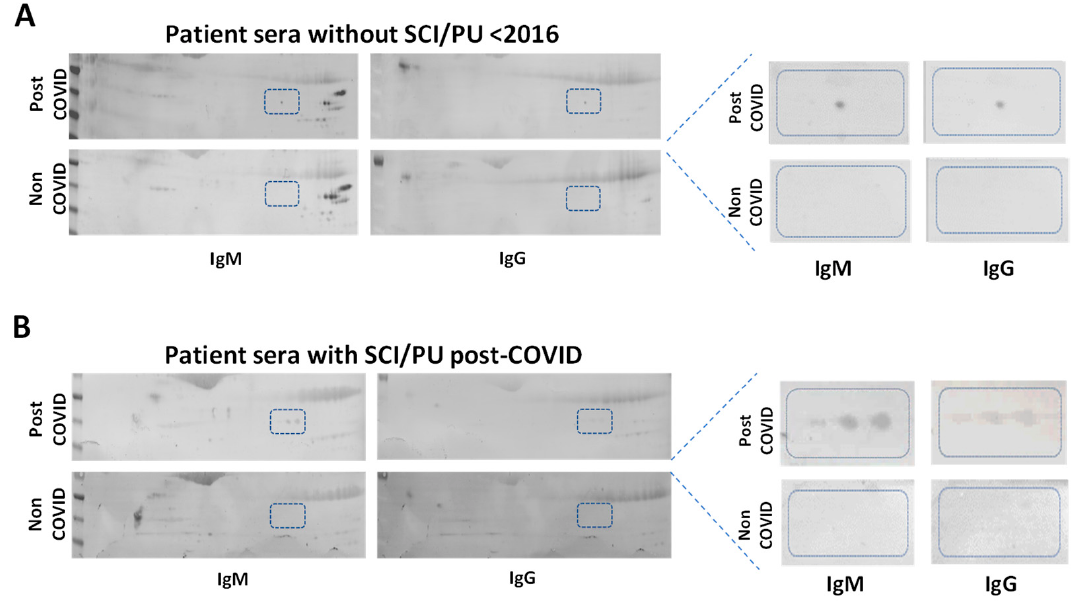
Figure 5. Evaluation of potential immunogenicity. ( A , B ) Representative 2D gels of s-WAT proteomes from both cohorts transferred to low-fluorescence PVDF membranes and incubated with sera from the different patient groups. The presence of autoantibodies is shown by the presence of dark spots using fluorescence-conjugated antibodies against human IgM and IgG. ( A ) The s-WAT of post-COVID (top) and non-COVID (bottom) patients, incubated with the serum of healthy volunteers without SCI and PU (all obtained before 2016). ( B ) The s-WAT of post-COVID (top) and non-COVID (bottom) patients, incubated with the serum of patients with SCI and PU post-COVID. Boxes with a dashed border indicate the marks selected in the